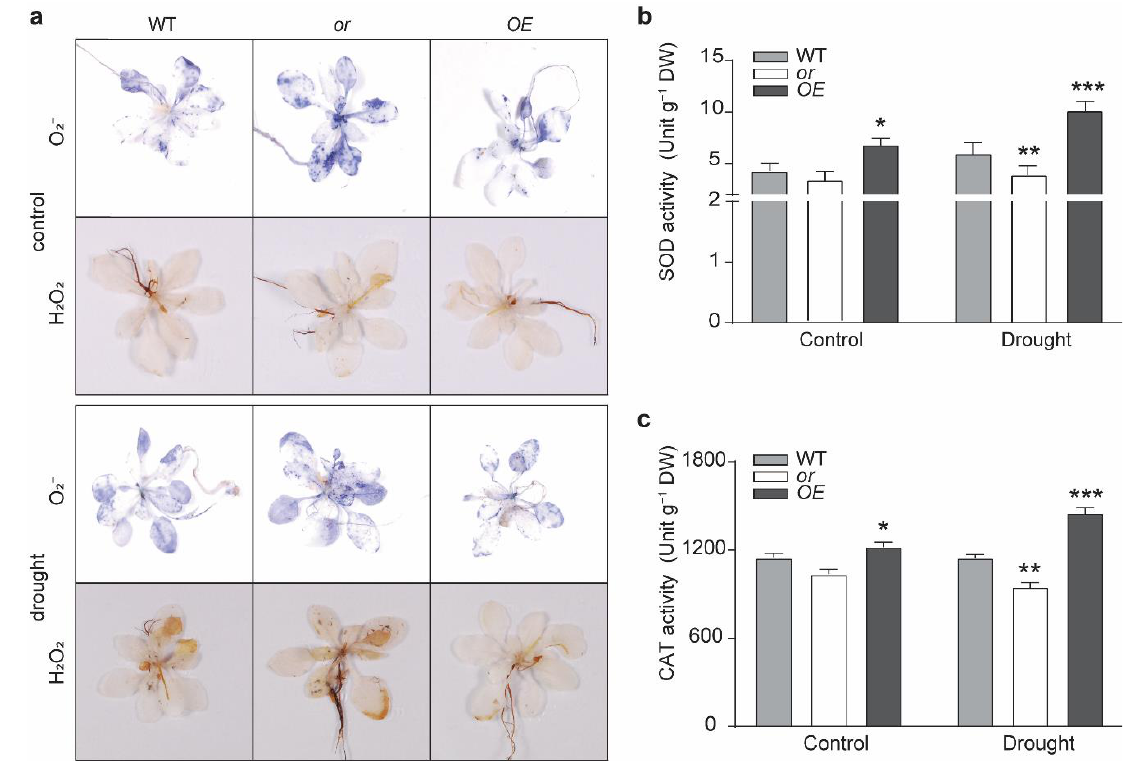
Figure 3. ROS production and antioxidative enzyme activities in OR transgenic seedlings. ( a ) Nitrotetrazolium blue chloride (NBT) and 3,3′ -diaminobenzidine (DAB) staining showed the production of O 2 − and H 2 O 2 in the wild-type (WT) and OR -overexpressing ( OE ) and -silencing ( or ) seedlings under normal growth conditions (control) and drought treatment. ( b , c ) Enzymatic activity of superoxidase (SOD) ( b ) and catalase (CAT) ( c ) in different lines under normal growth conditions (control) and drought treatment. Data are means ± SEM ( n = 3, * p < 0.05, ** p < 0.01, *** p < 0.001, or better, Student’s t test). DW, dry weight.